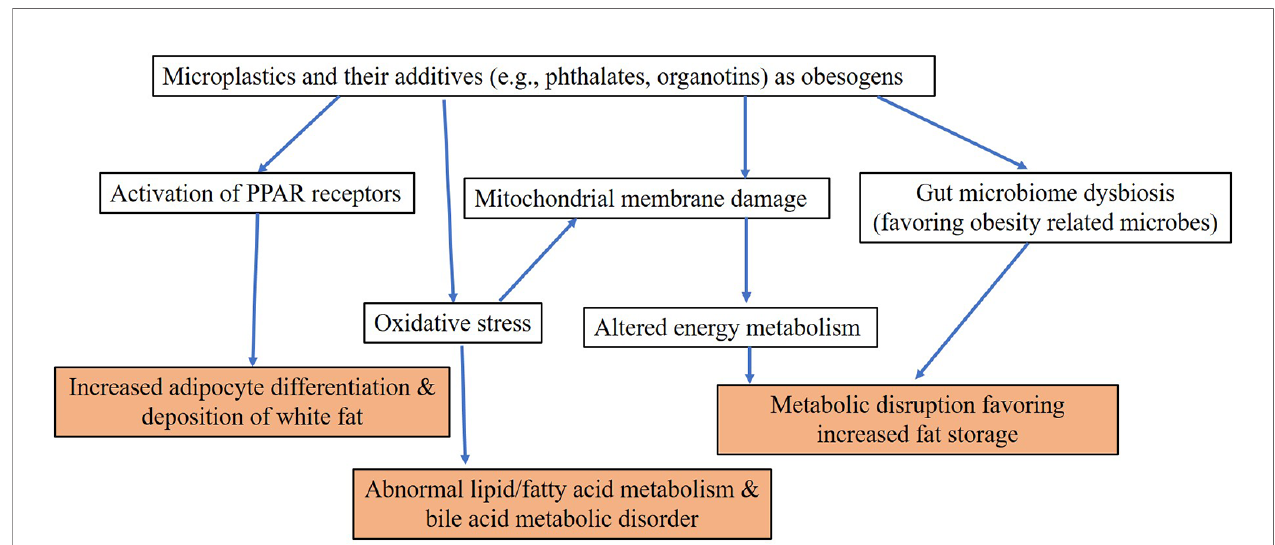
FIGURE 3 | Proposed mechanisms of obesogenic effects of microplastics and their